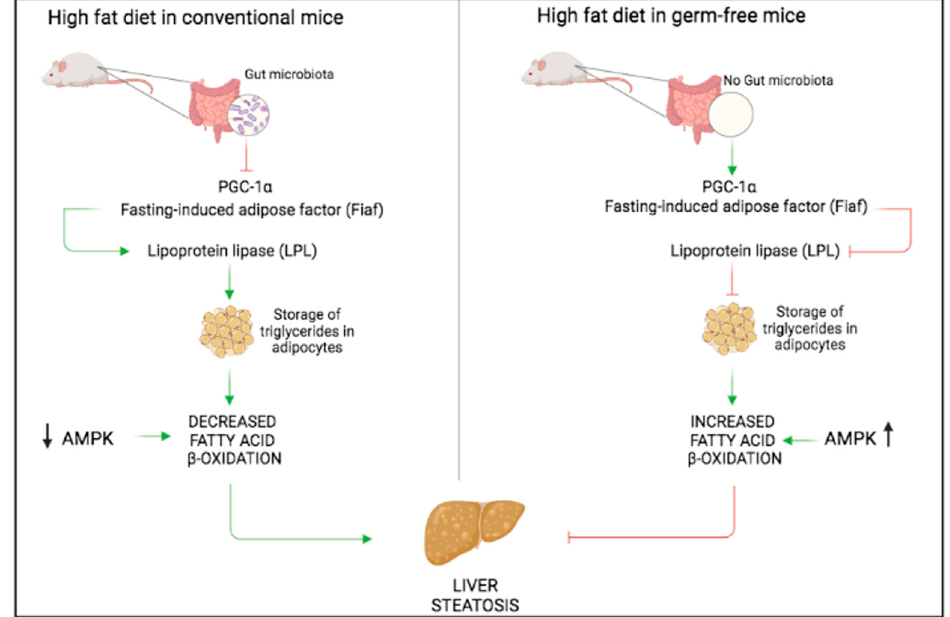
Figure 4. The gut microbiota regulates fat storage. The gut microbiota favors lipoprotein lipase (LPL) activation through inhibition of the fasting-induced adipose factor (Fiaf). This enhances triglycerides storage in adipose tissue and decreases fatty acid oxidation via suppression of AMP-activated protein kinase (AMPK) activity, thus leading to heightened adiposity and liver fibrosis. On the contrary, in germ-free mice, the absence of the gut microbiota favors resistance to diet-induced adiposity through inhibition of LPL and activation of AMPK.